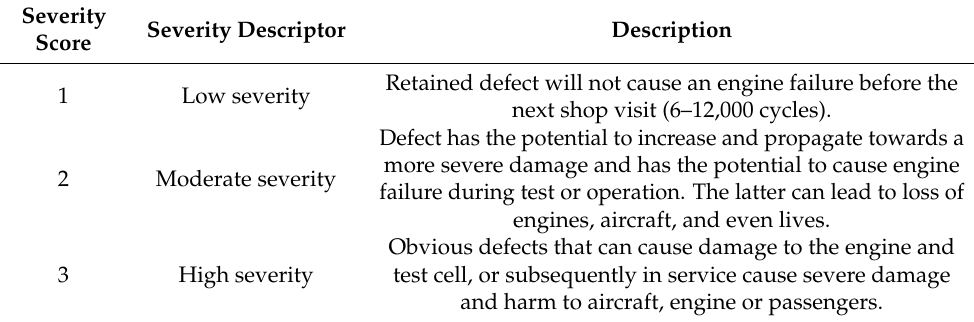
Table 7. Qualitative severity scoring